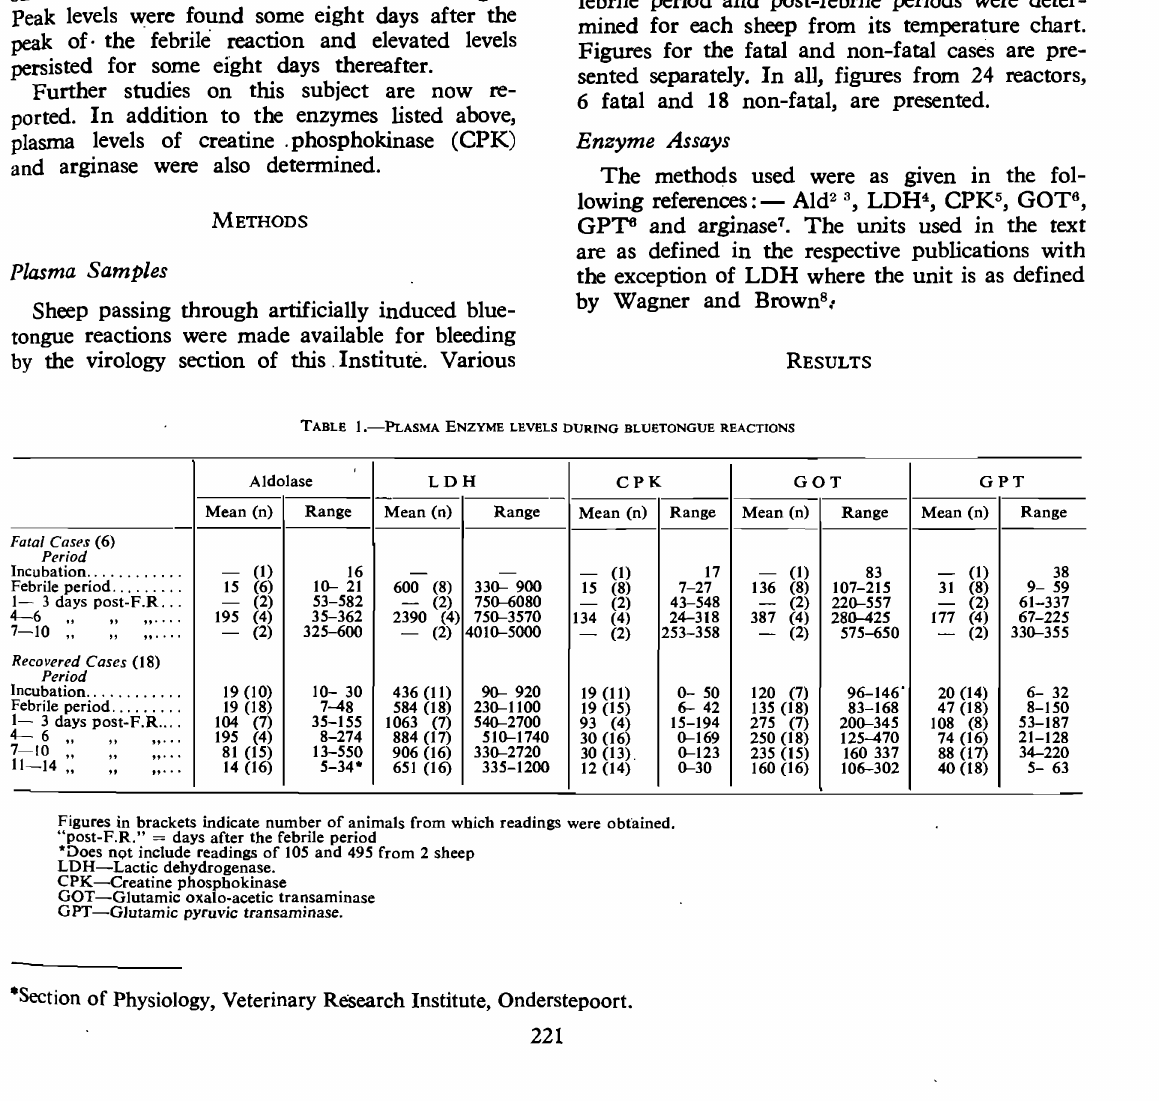
TABLE t.-PLASMA ENZYME LEVELS OURING BLUETONGUE REACTIONS